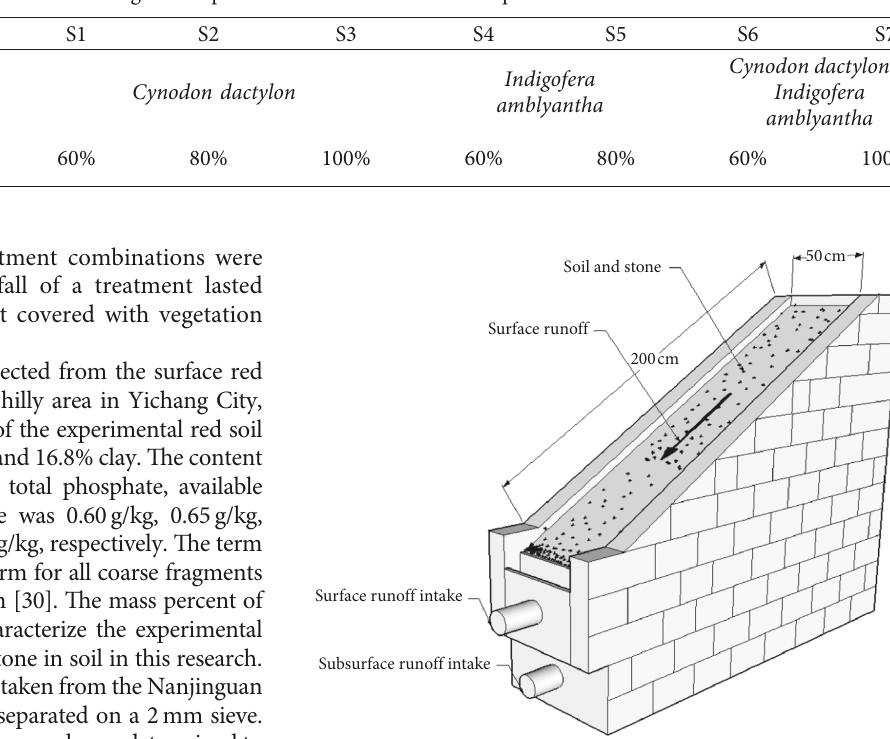
Table 1: Vegetation patterns in the different runoff plots.